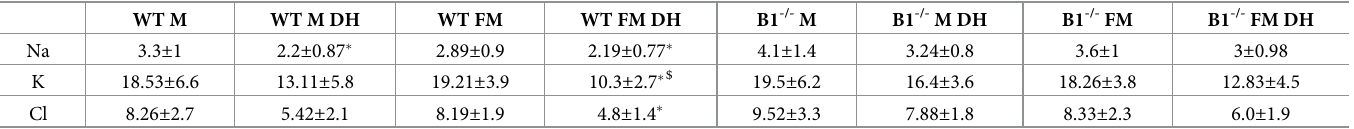
Table 1. Effect of dehydration on 12 h urinary excretion of Na, K, and Cl. WT